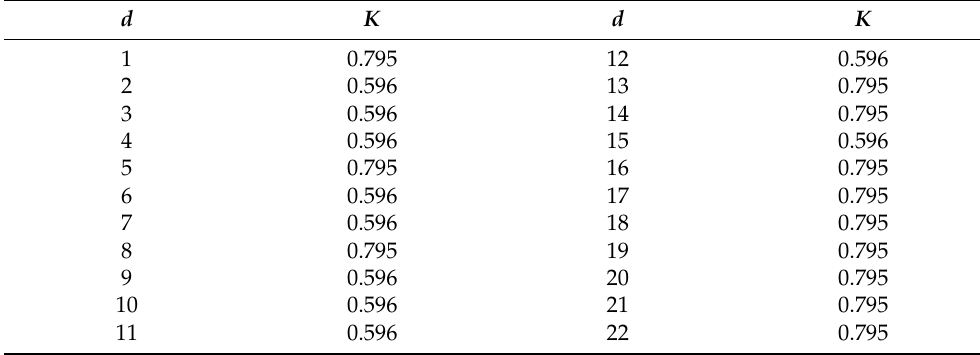
Table 2. Numerical values of soil hydraulic conductivity ( k ) in 22 agrology boreholes ( d ) using the inverse auger hole laboratory